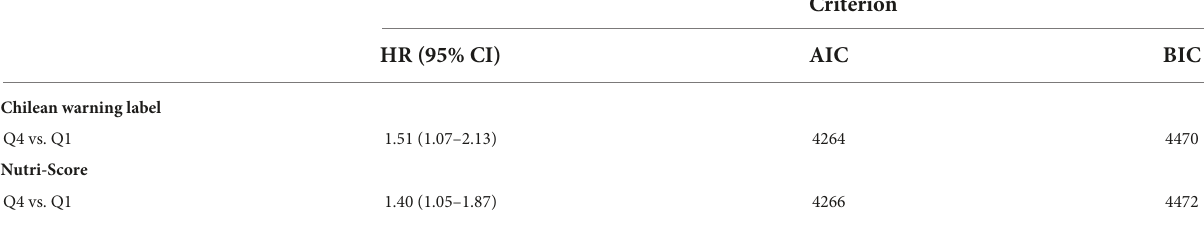
TABLE 4 Comparison of AIC and BIC values for the warning label score and Nutri-Score in relation to all-cause mortality.